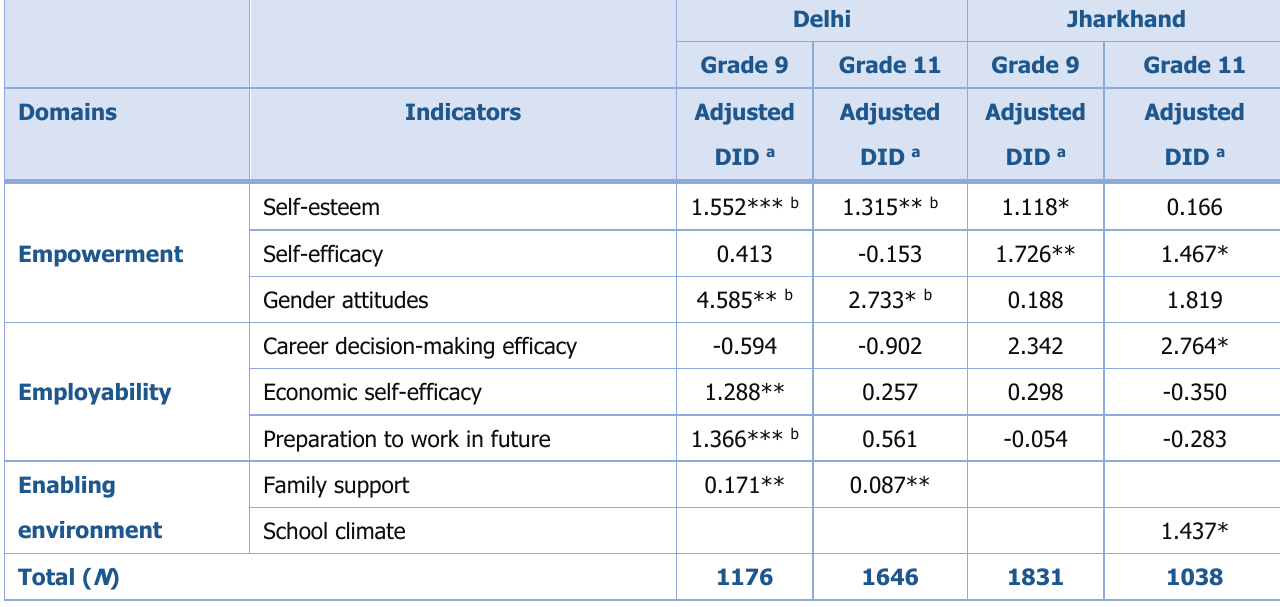
Table 5. Program Impact (Adjusted DID) in Empowerment and Employability Indicators